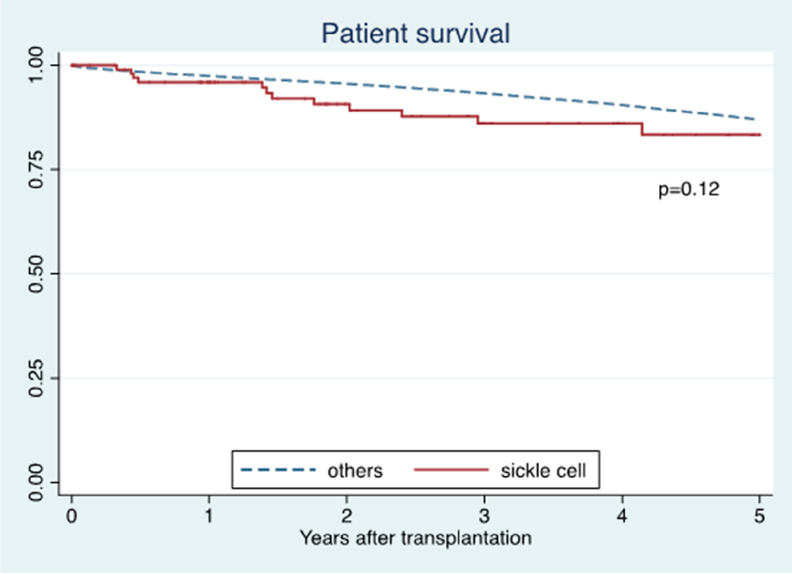
Figure 2. Patient survival of sickle cell disease compared to non-sickle disease recipients.